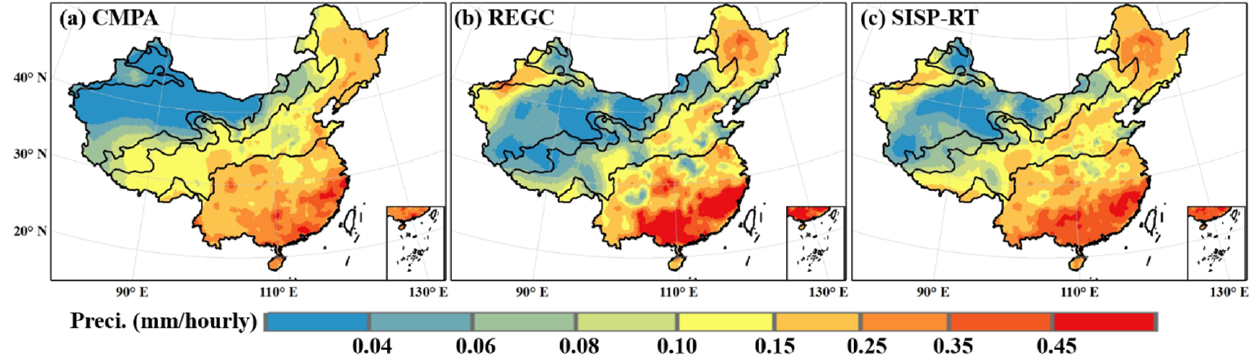
Figure 5. Spatial distribution of mean hourly precipitation for CMPA, REGC, and SISP-RT (June to August 2019).